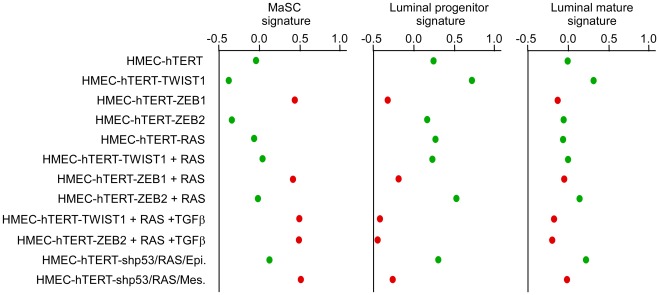
Expression of EMT–inducing transcription factors triggers a dedifferentiation of HMEC cells.Mammary stem cells (MaSC), luminal progenitor and luminal mature signatures of human cell line are defined according to Lim and collaborators [25], respectively. High scores are indicative of a good correlation between the analyzed gene expression profiles and the established signatures. Cells lines with an epithelial morphology are labeled in green while cell lines harboring a mesenchymal morphology are labeled in red.